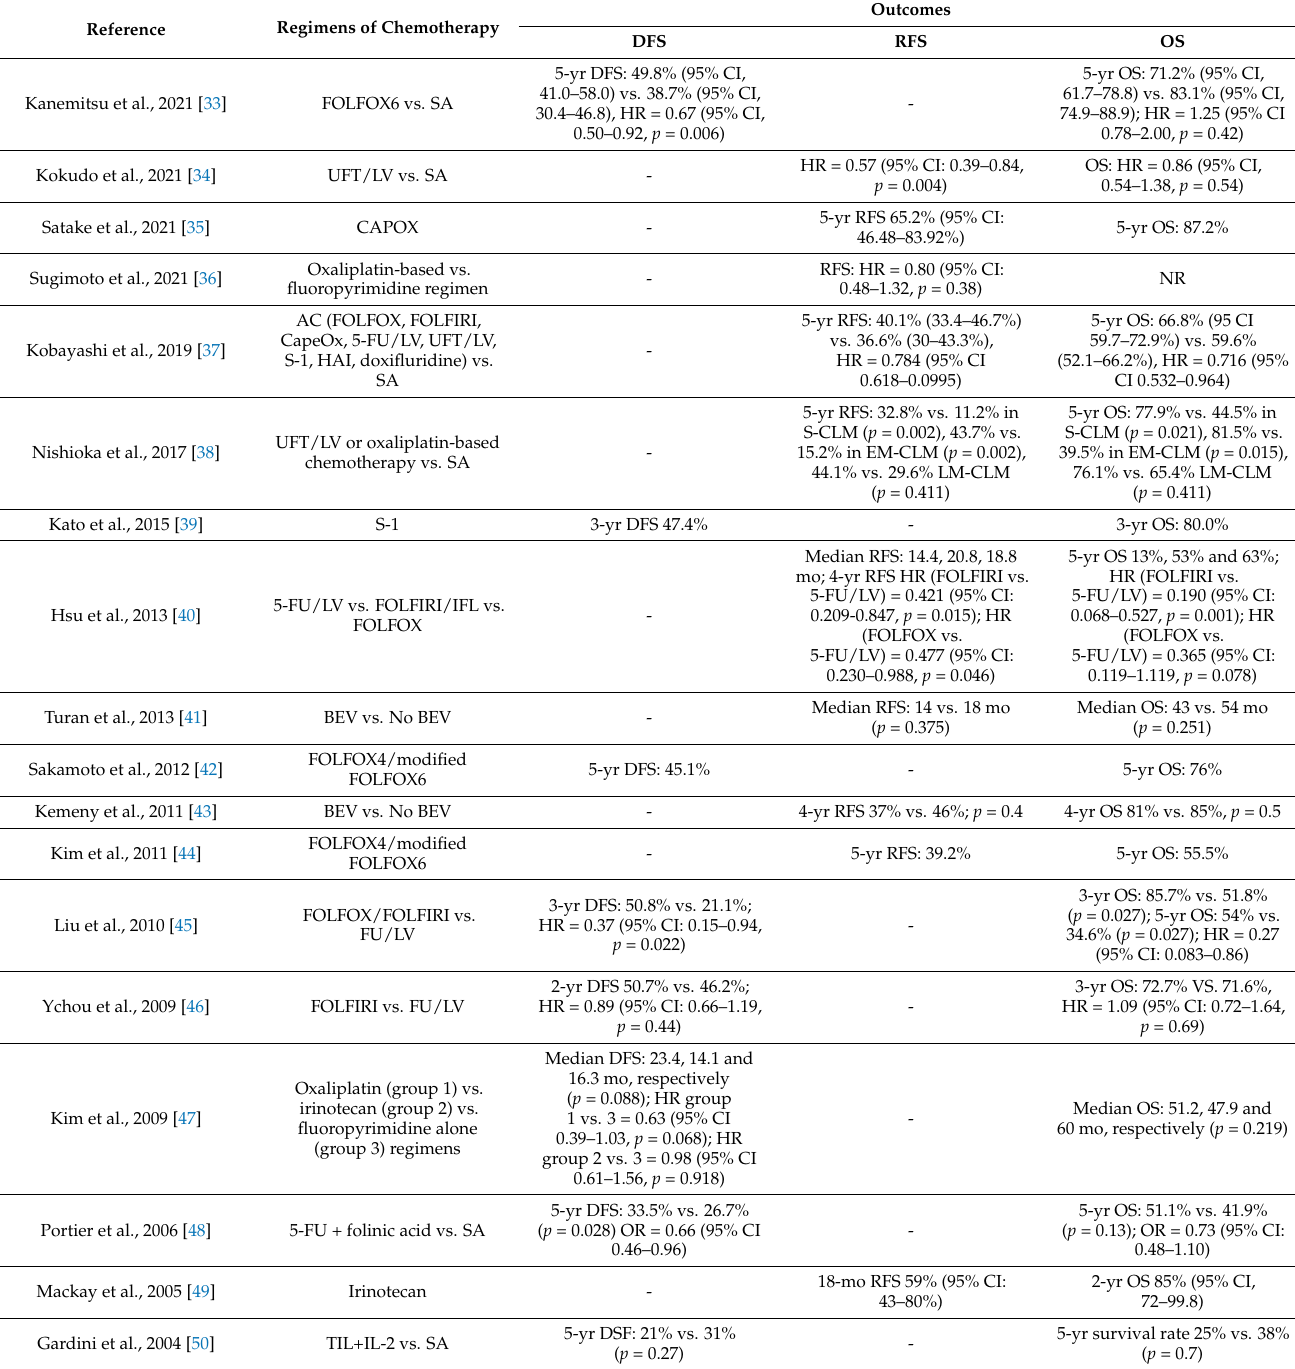
Table 3. Outcomes of studies investigating systemic adjuvant systemic